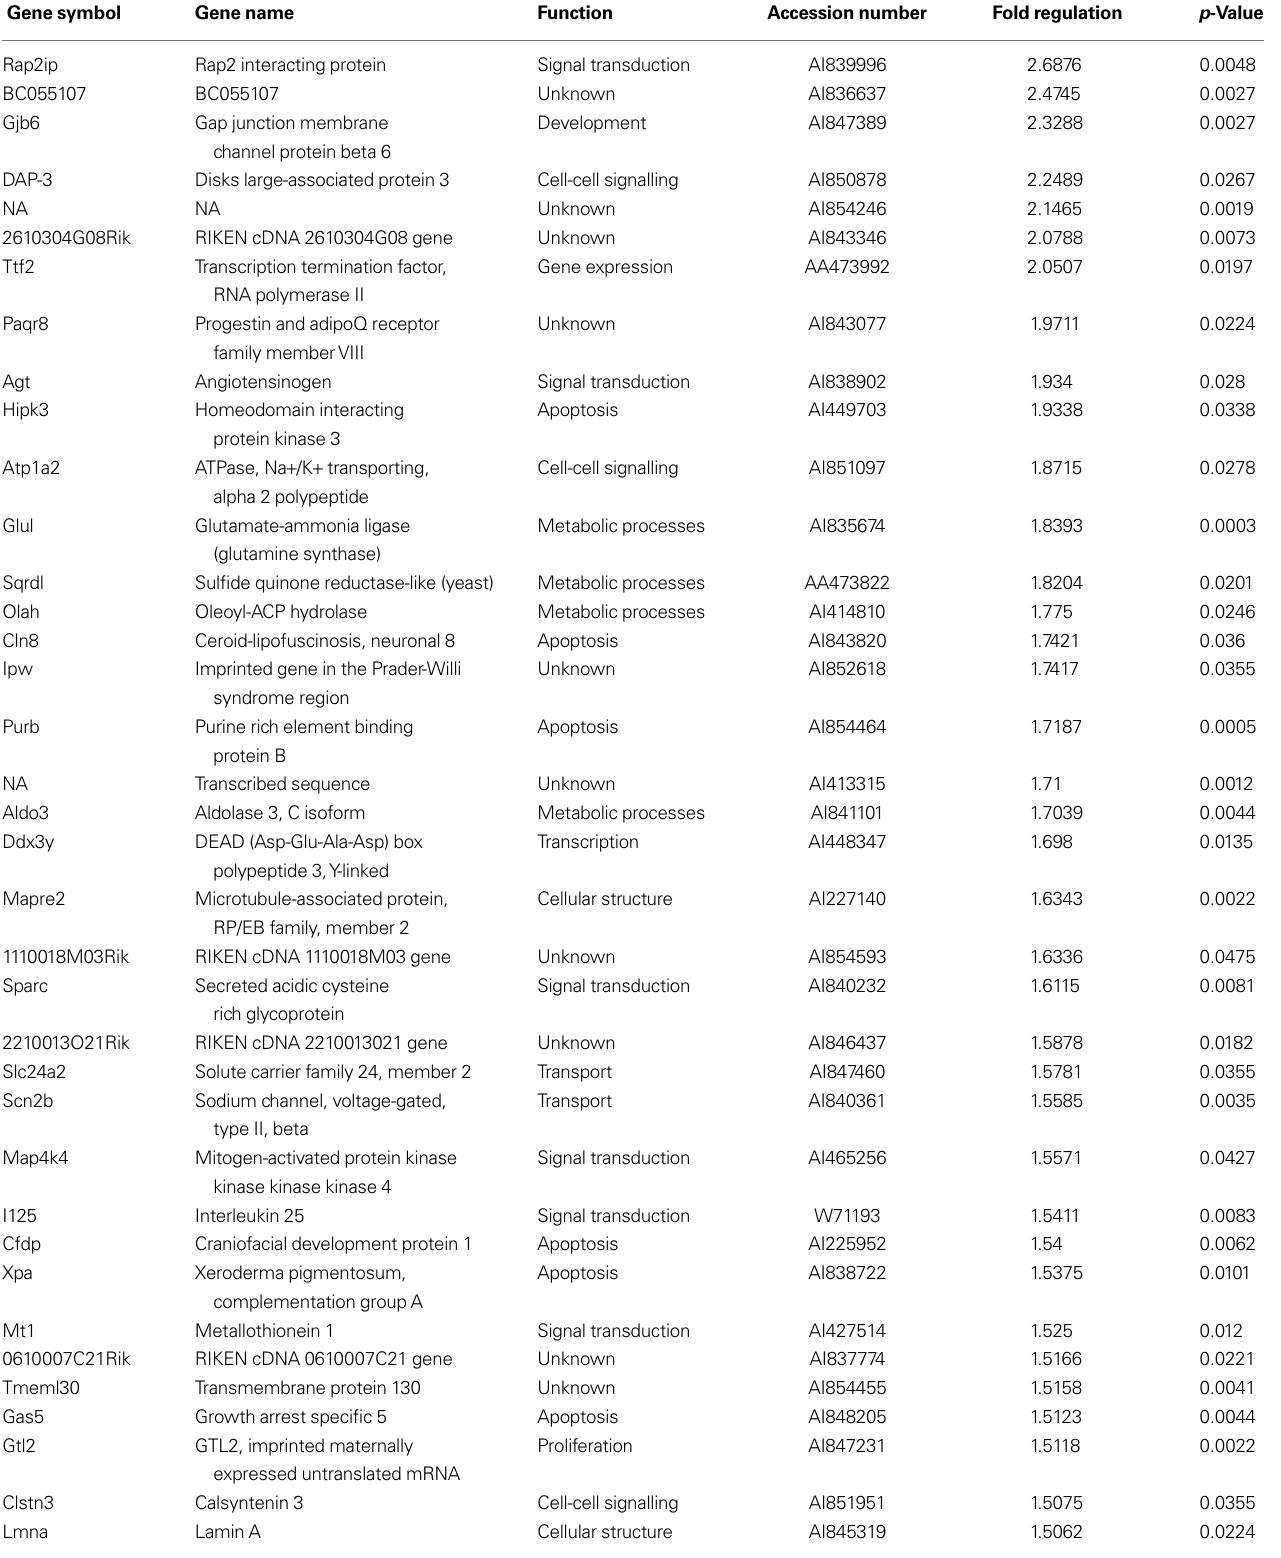
Table 1 | List of signifi cantly up-regulated genes in the PVN region of the hypothalamus in 9-day-old maternally separated mouse pups compared to